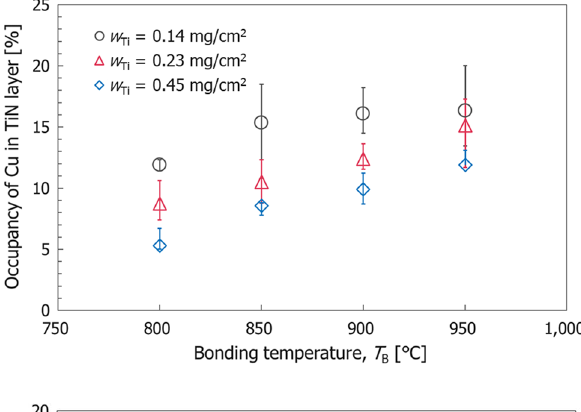
Fig. 6 Peel strength at Cu/AlN interface as a function of the amount of Ti